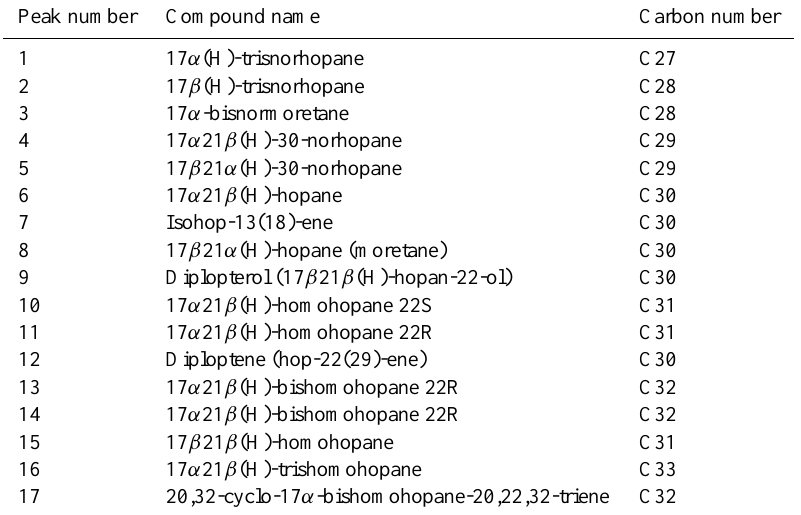
Table 3. Pentacyclic triterpenoids identified in Perejil MV crater and flank, Kalinin and Schneider’s Heart MVs. Peak number Compound